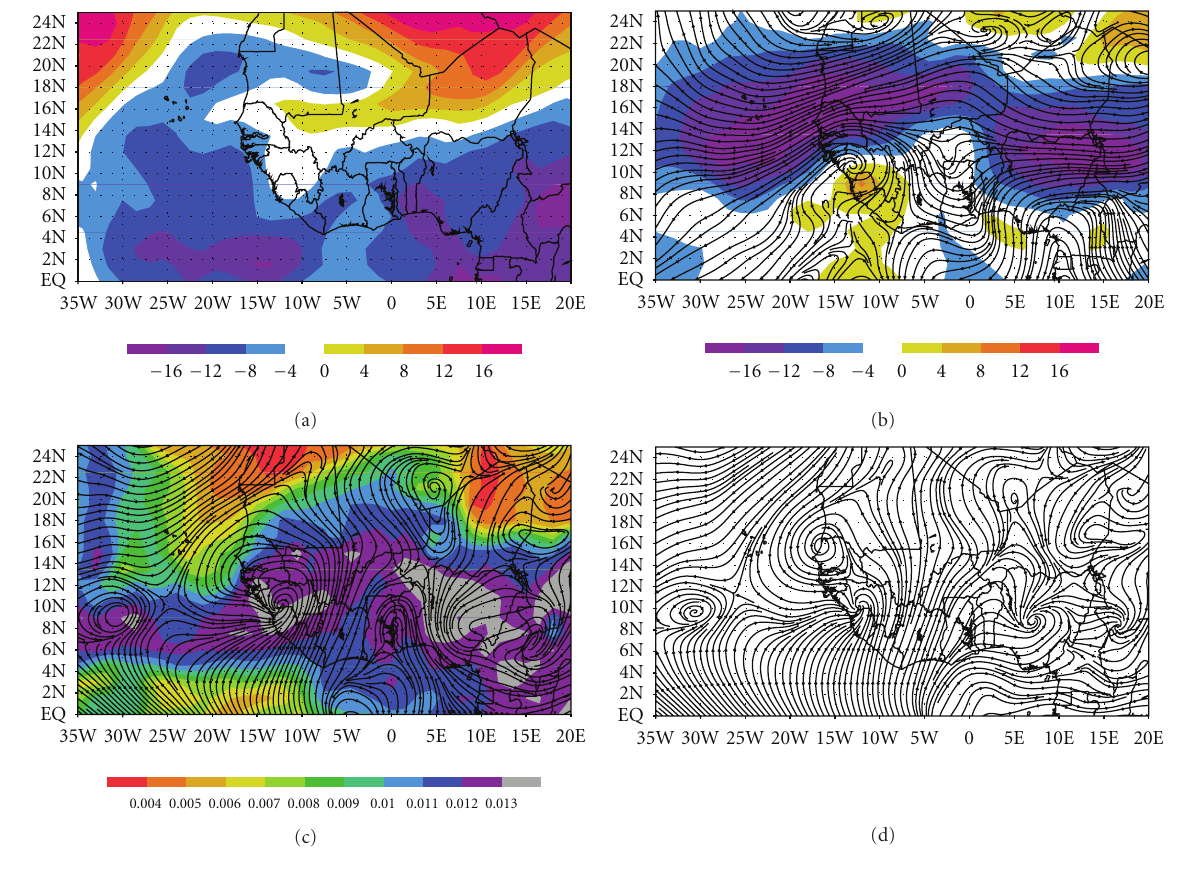
Figure 5: (a) ECMWF Reanalysis zonal winds (ms − 1 ) at 1200 UTC 11 September for 200 hPa. (b) Composite ECMWF Reanalysis zonal winds (ms − 1 ) and streamlines at 1200 UTC 11 September for 650 hPa. (c) Composite ECMWF Reanalysis specific humidity (kg kg − 1 ) and